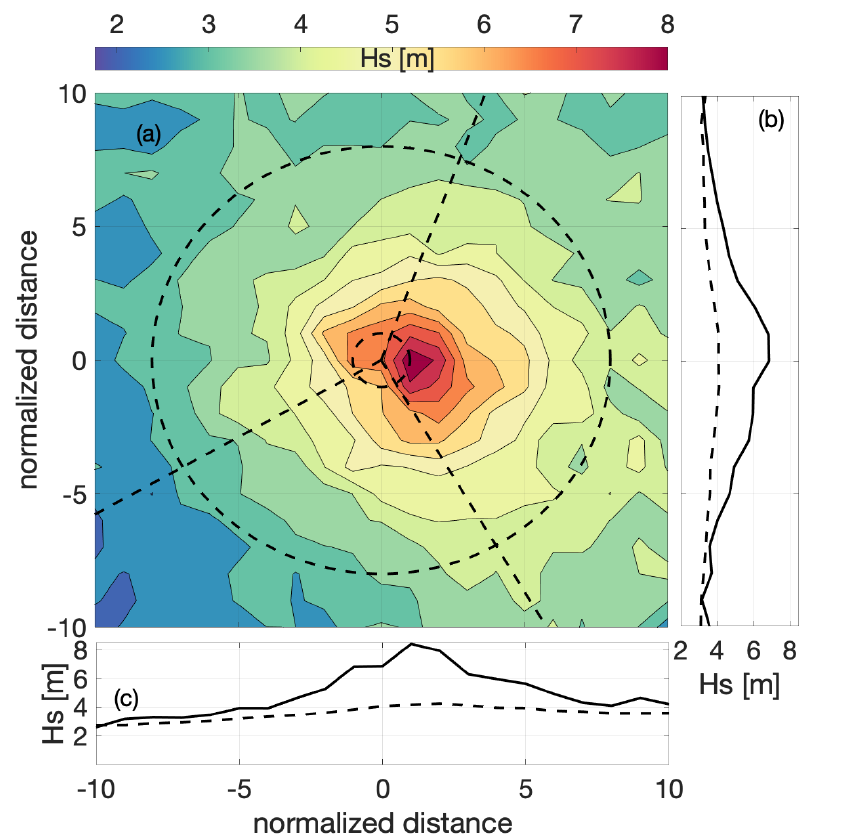
Figure 3. Average wave height observed by altimeters in a TC-centered reference frame ( U r ≥ 33 m/s). ( a ) Color scale indicates average wave height observed in 2 R × 2 R bins, with contour lines every 0.5 m. Small dashed circle is R = 1; larger dashed circle is R = 8. Dashed lines show TC sectors according to [27]. Up arrow is the orientation of the TC, moving forward up the page. ( b ) Solid line is a back to front transect along nX = 0 and the dashed line is the average along the nX axis. ( c ) as in ( b ) for